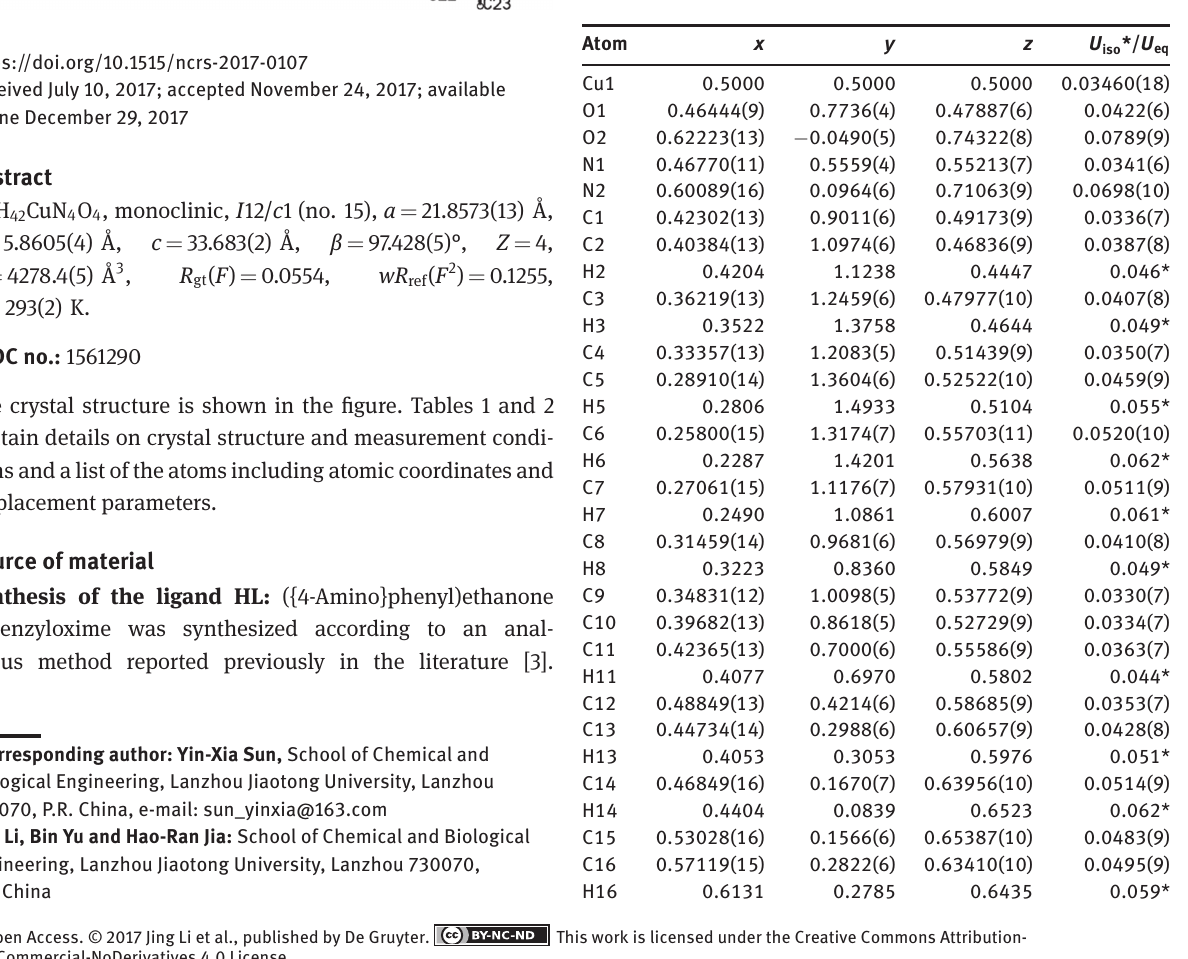
Table 2: Fractional atomic coordinates and isotropic or equivalent isotropic displacement parameters (Å 2